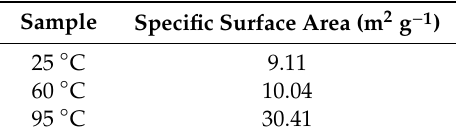
Table 3. The specific surface area of as-deposited materials.